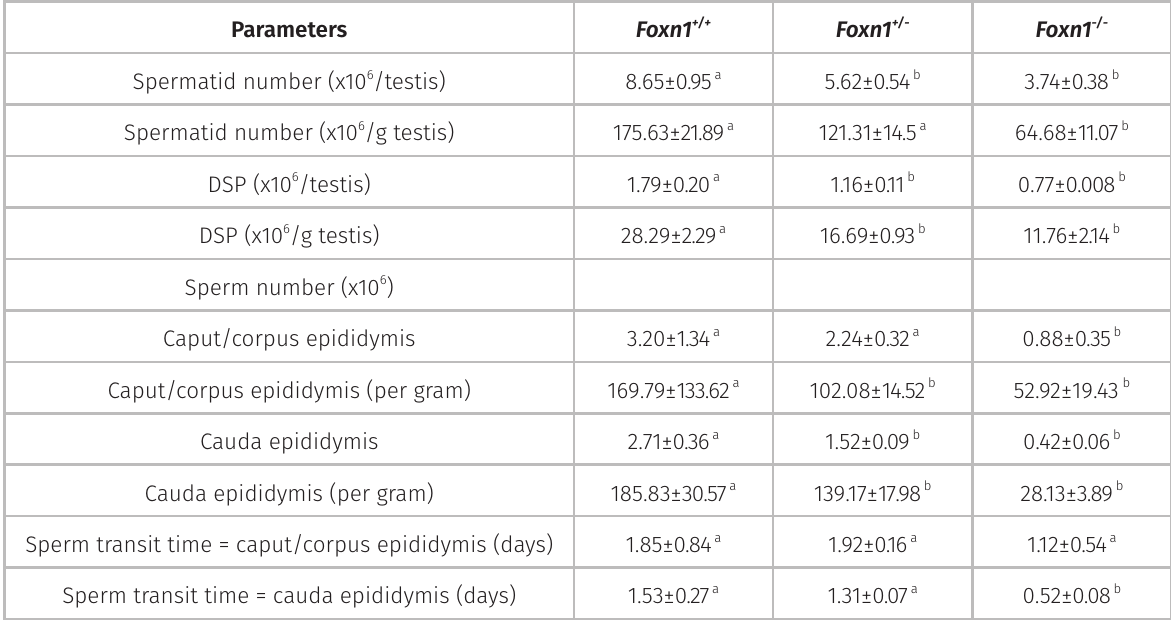
DSP: daily sperm production. n = 4 males/ group. Different superscripts ( a,b ) in the same row are P<0.05 . Values are mean ± S.D. ANOVA with SNK post hoc